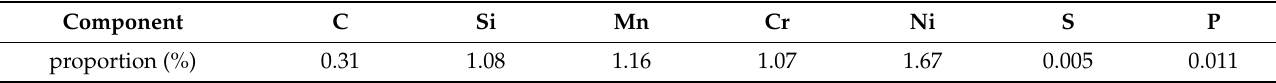
( c ) Figure 4. Test results: ( a ) penetration depth; ( b ) crater depth; ( c ) crater diameter.